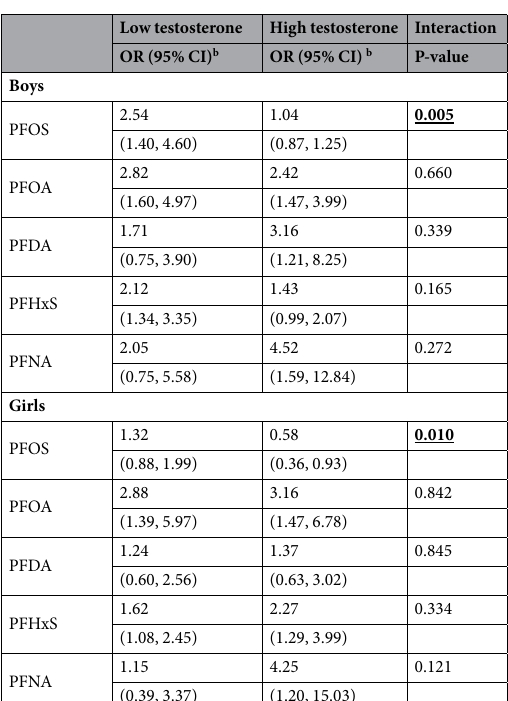
Table 3. Interaction effects of PFASs (ng/mL) and testosterone category on asthma, by sex ab . a low vs high grouped according to median testosterone level. b All models adjusted for age, sex, body mass index, parental education, environmental tobacco smoke exposure, physical activity, and month of